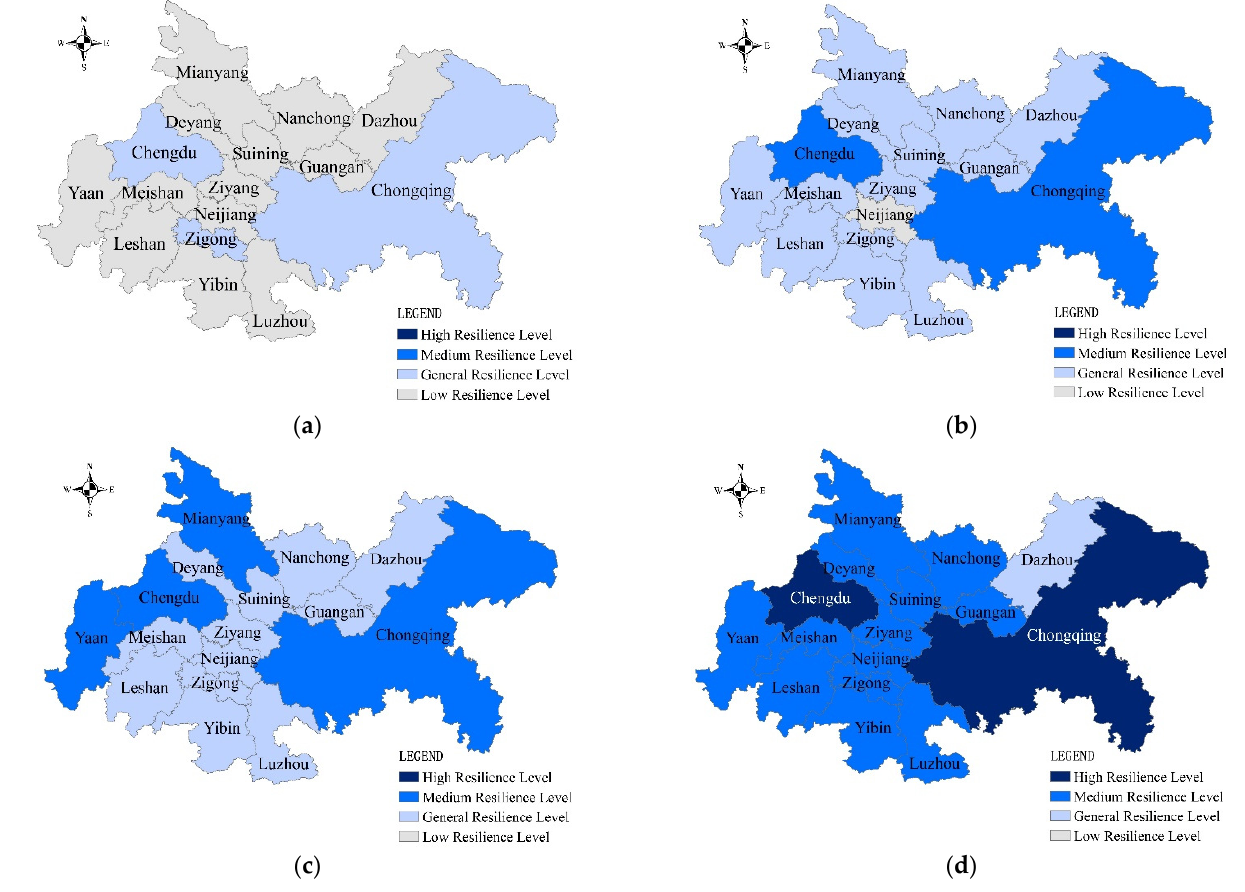
Figure 3. Spatial evolution of urban resilience in the Chengdu–Chongqing urban agglomeration. ( a ) 2005. ( b ) 2010 . ( c ) 2015. ( d ) 2019 .